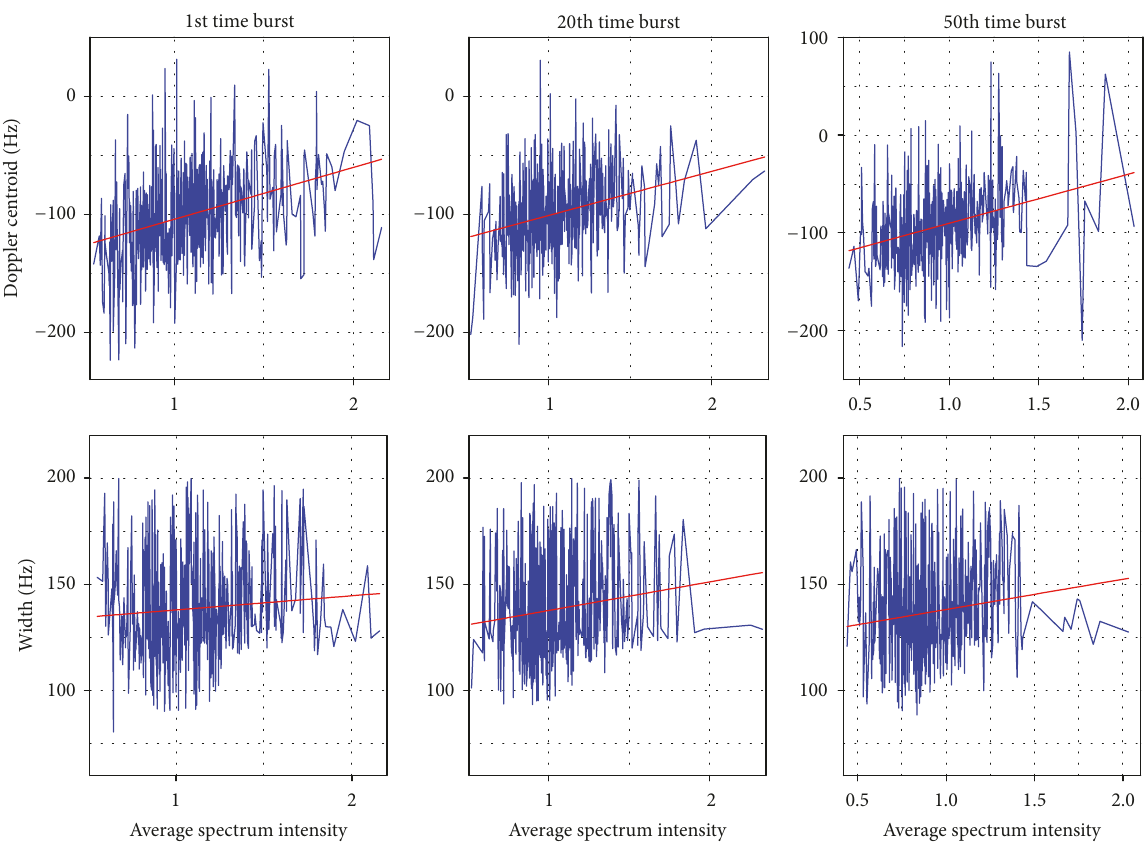
Figure 24: Spectra parameters versus intensity for the azimuth difference channel, with least-mean-square error straight-line fit: blue, data; red, model fit.